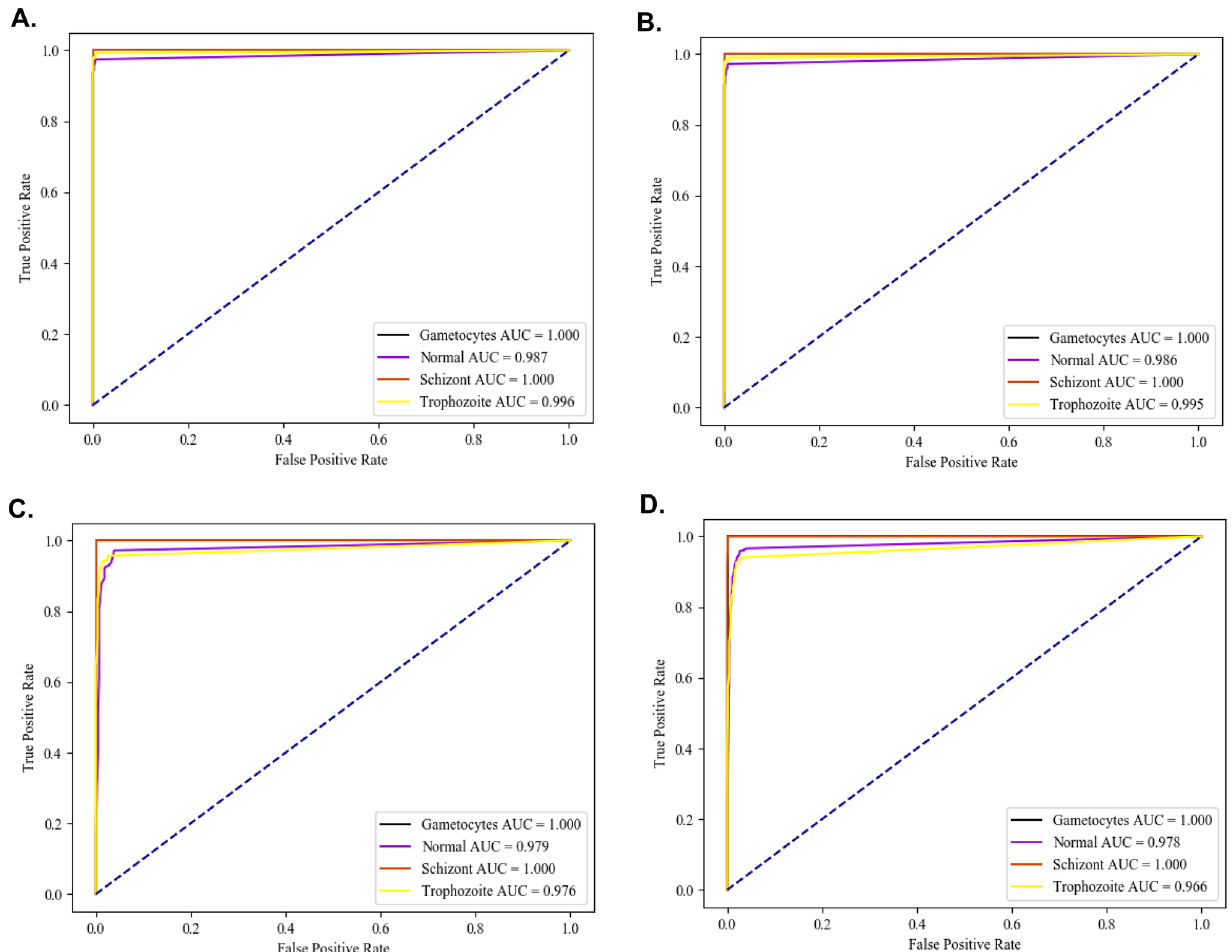
Figure 2. The AUC under the ROC curve analyzed by the model- wise performance following; ( A ) Darknet, ( B ) Darknet19, ( C ) Darknet19_448 and ( D ) Densenet201, respectively. Besides, the plot also present class-wise comparison following; Gametocyte, Normal RBC, Schizont and Trophozoite, respectively. All images were plotted under the CiRA CORE plug-in encoded by using Python 3.5.0 (https:// launc hpad. net/ ~deads nakes/+ archi ve/ ubuntu/ ppa), matplotlib 3.4.2 (https:// pypi. org/ proje ct/ matpl otlib/) and pandas 1.3.1 (https:// pypi. org/ proje ct/